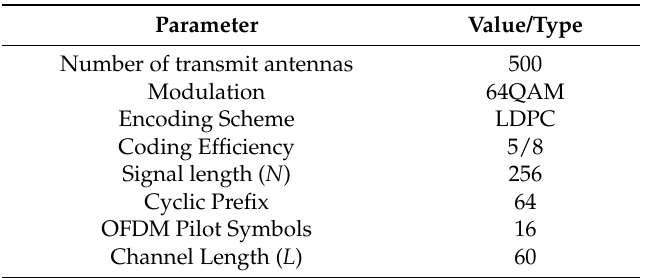
Table 1. Simulation Parameters. LDPC: low-density parity-check; OFDM: orthogonal frequency- division